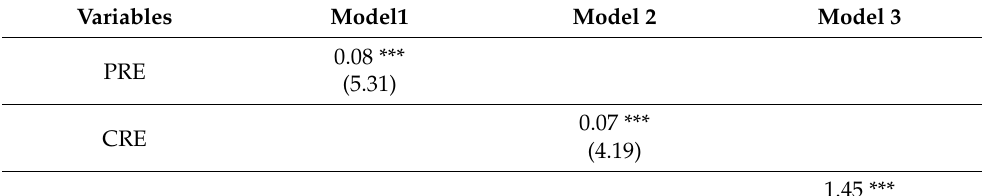
Table 5. Estimations of Fixed effects